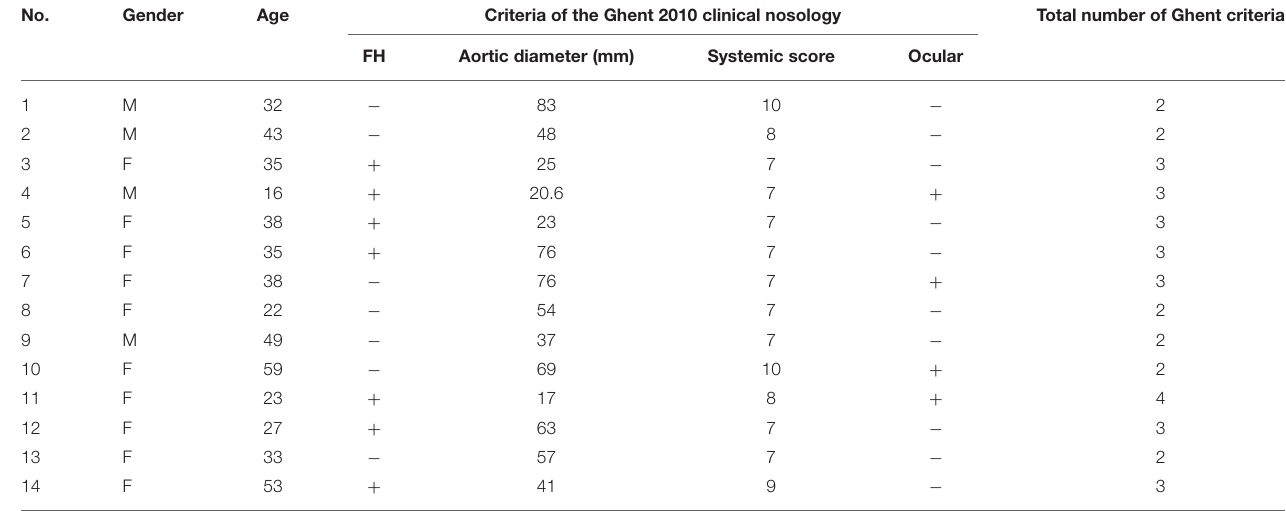
MFS, Marfan syndrome; F, female; M, male; FH, family history.